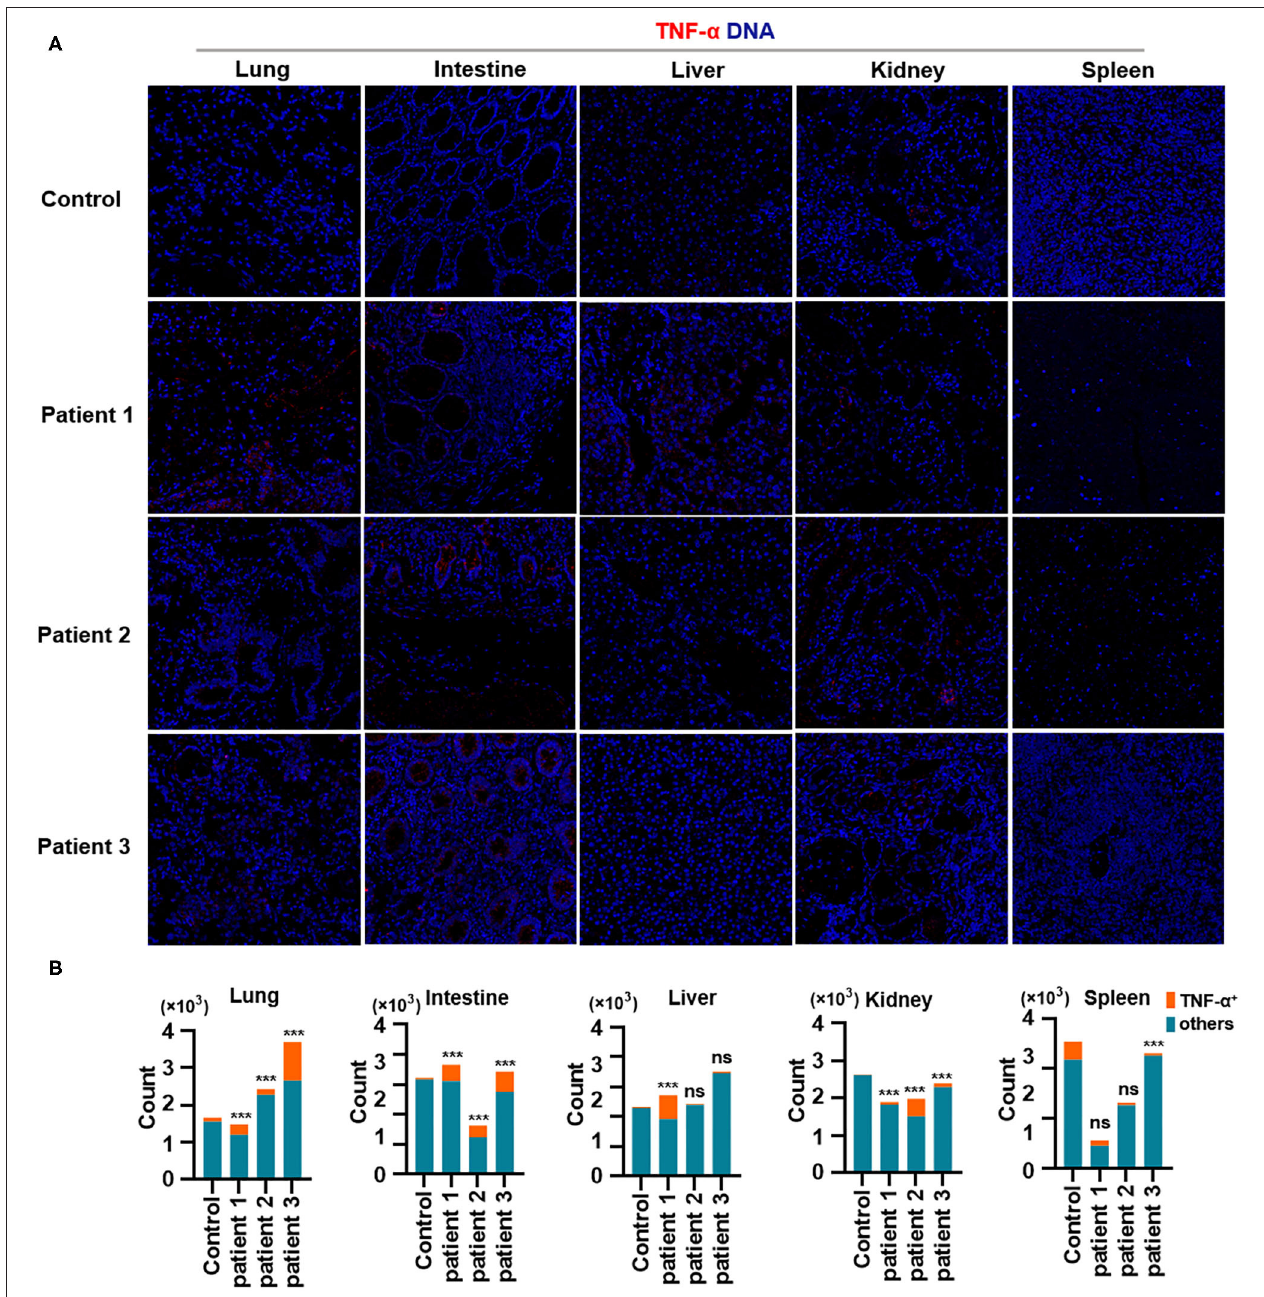
FIGURE 5 | Production of TNF- α in tissues from patients with coronavirus disease-2019 (COVID-19). (A) Imaging mass cytometry (IMC) for TNF- α in the lungs, intestine, liver, kidneys, and spleen from controls or patients with COVID-19; iridium-DNA staining is shown in blue, and TNF- α staining is shown in red. (B) Bar plot for the comparison of TNF- α in the lungs and intestine of controls and three patients with COVID-19. The significance of differences between groups is shown as horizontal brackets and was assessed using Fisher’s exact test. *** P < 0.01; ns, P >